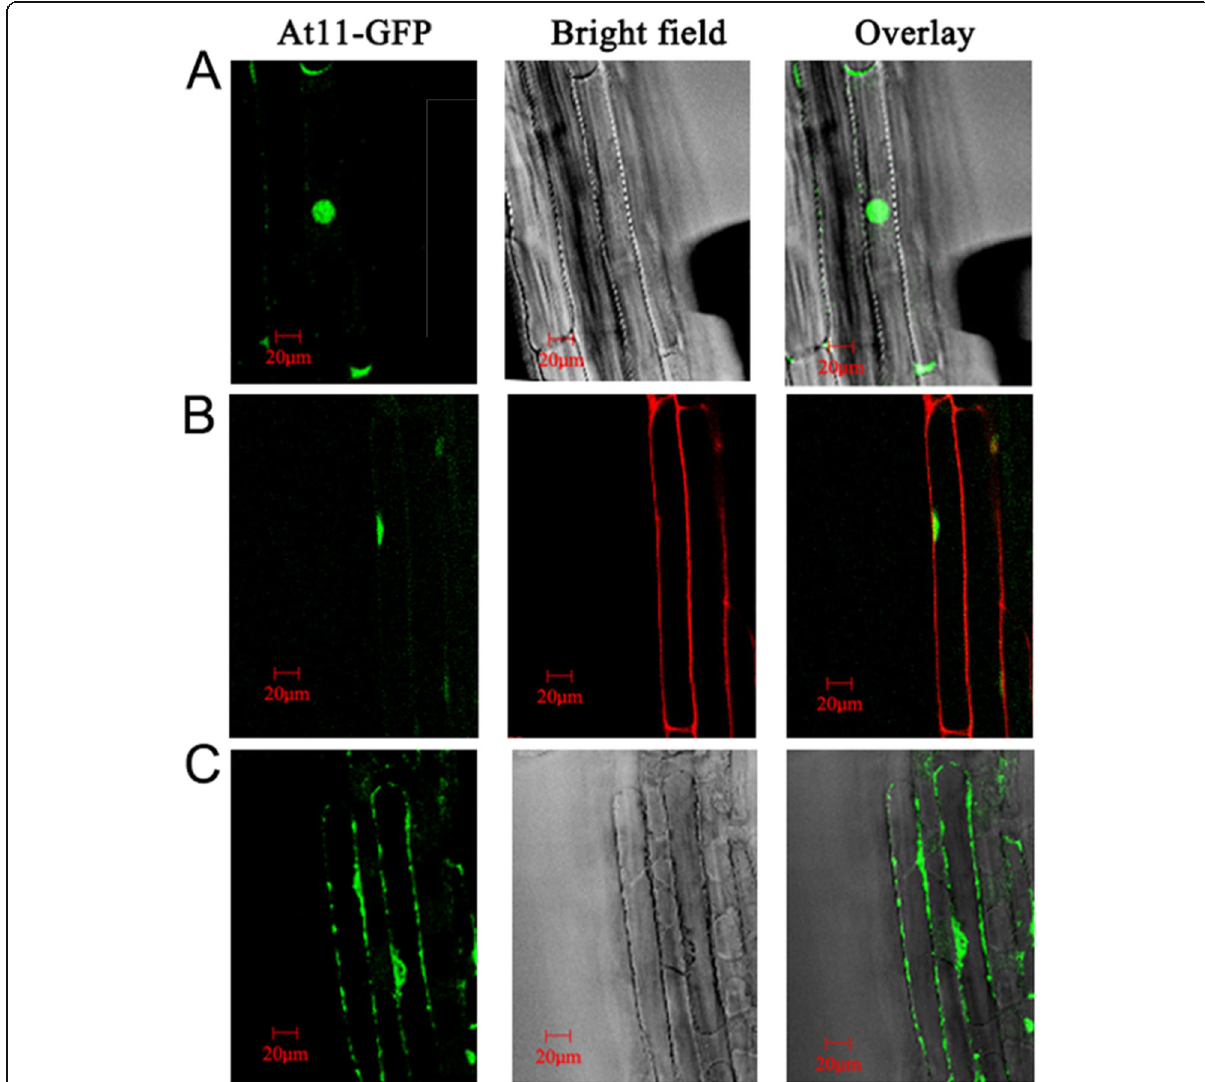
Fig. 4 Subcellular localization of GbAT11 in roots of transgenic Arabidopsis thaliana . a This image shows the localization of GFP-GbAT11 fusion protein in Arabidopsis cells, and green fluorescence appears under laser scanning confocal microscopy . b Laser scanning confocal microscopy showing the GbAT11 protein was localized in the nucleus after PI treatment . c Laser scanning confocal microscopy observed that GbAT11 protein was localized in the nucleus, and localized on the cell membrane after plasmolysis with 20% sucrose solution treatment of